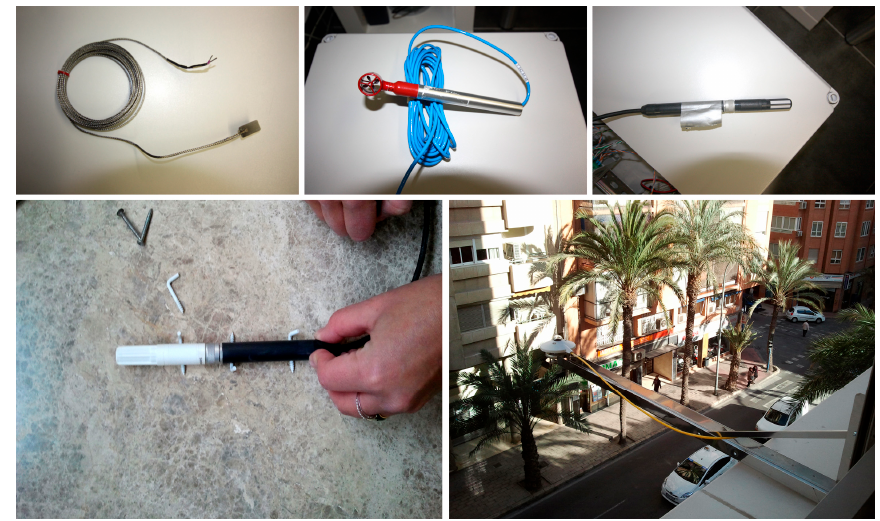
Figure 7. Sensors for surface temperature, anemometer and environment temperature; and pyranometer.